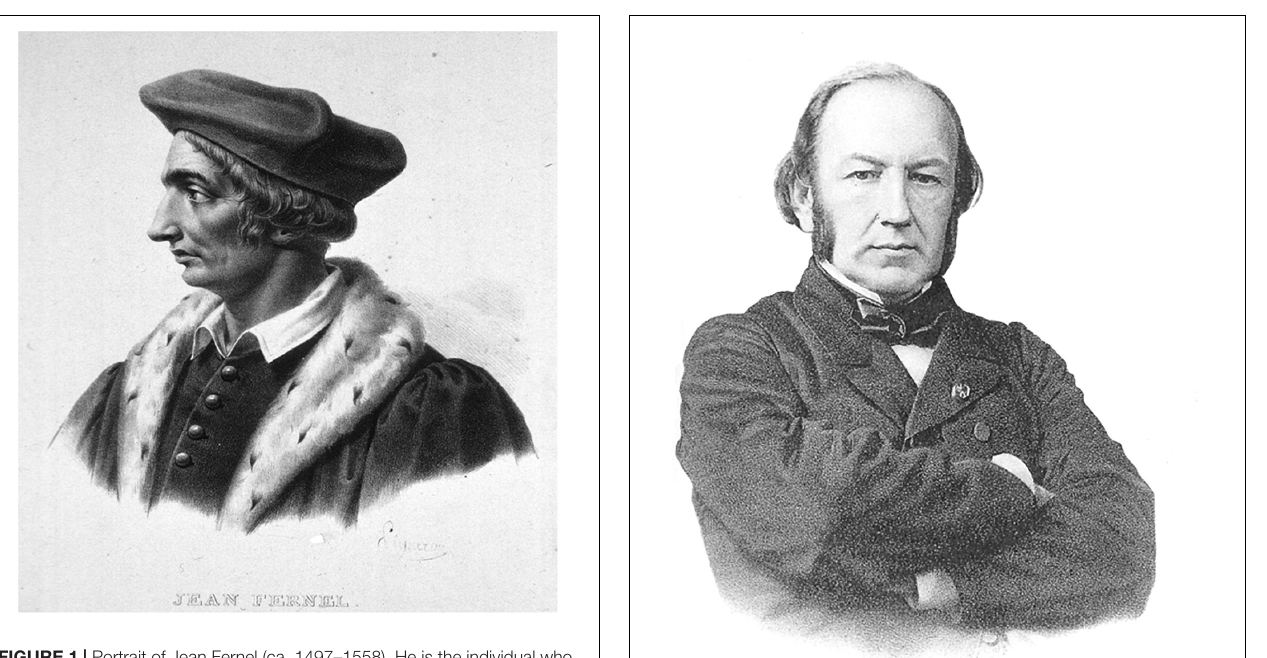
FIGURE 1 | Portrait of Jean Fernel (ca. 1497–1558). He is the individual who coined the term physiology. Source: National Library of Medicine (the history of medicine public domain image files). FIGURE 2 | Photograph of Claude Bernard (1813–1878). He developed the concept of “ a fixité du milieu intérieur ,” that is, organisms maintain a stable